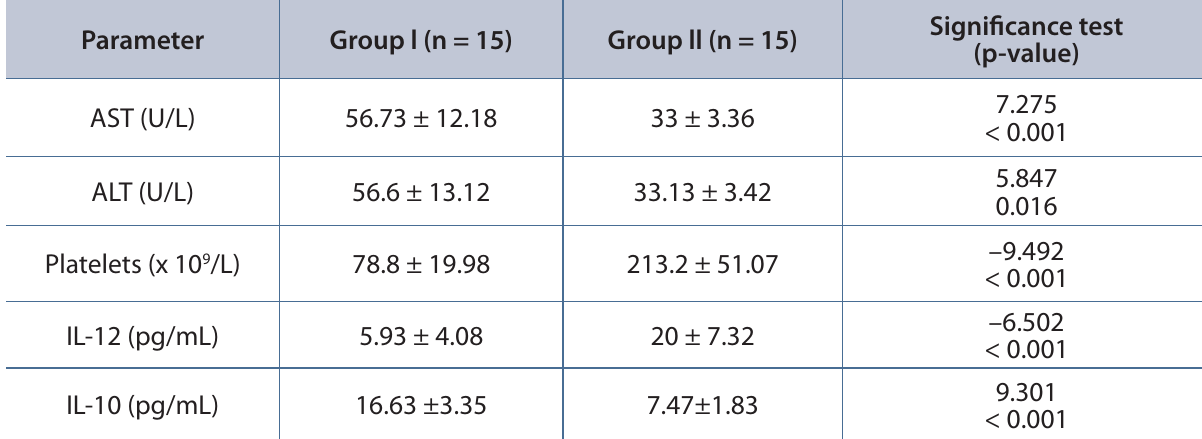
Table 2. Laboratory data of the studied groups